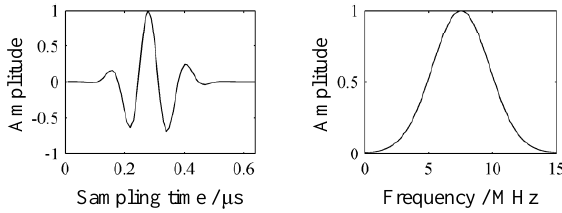
Figure 3. Transmission pulse signal and spectrum of transducer.